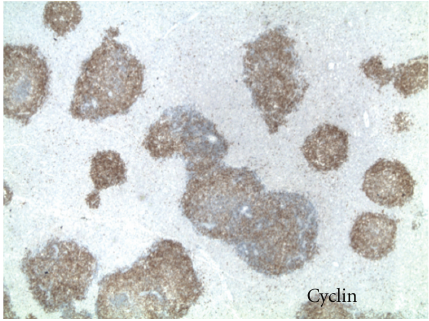
Figure 4: Immunohistochemical staining positive for cyclin D- 1 correlating with the t(11;13) translocation of the short arm of chromosome 13, which is highly specific for MCL.